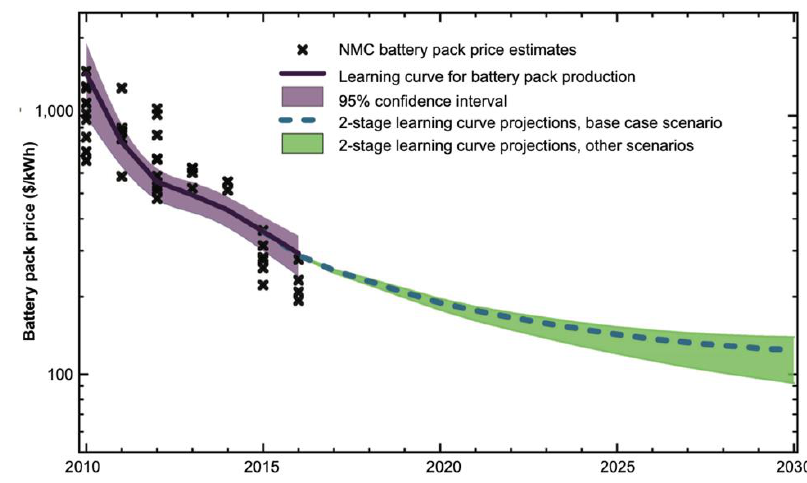
Figure 1. Past and projected price trajectory for lithium-ion NMC battery packs [26].